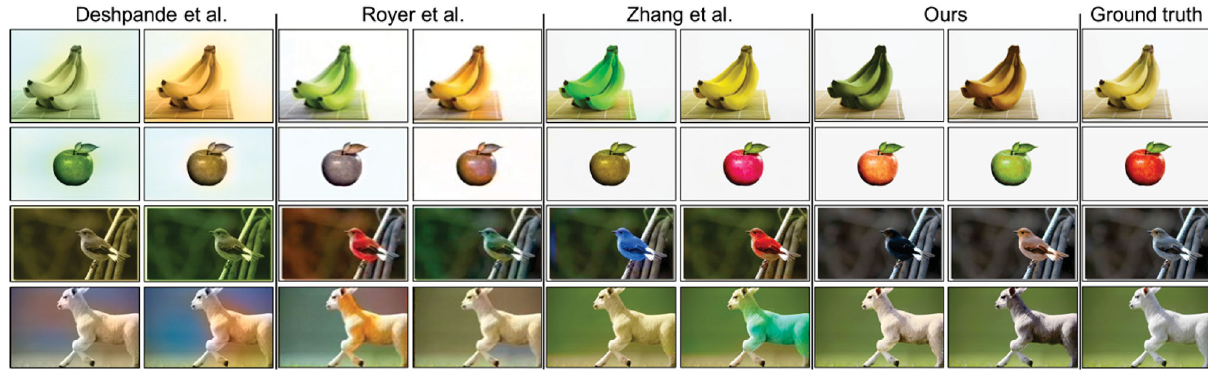
Fig. 9 Comparison of our method with those of Zhang et al. [45], Deshpande et al. [15], and Royer et al. [16]. Each row shows colorization of one image, giving two colorization results for each method.